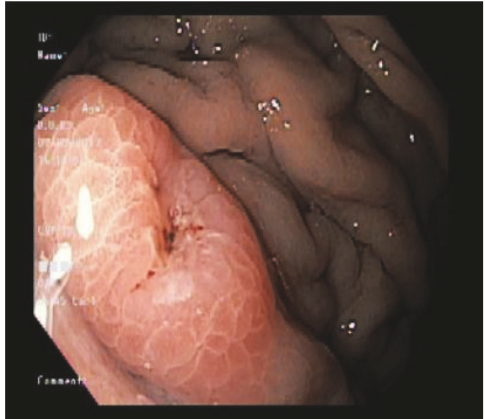
Figure 1: Candidiasis.